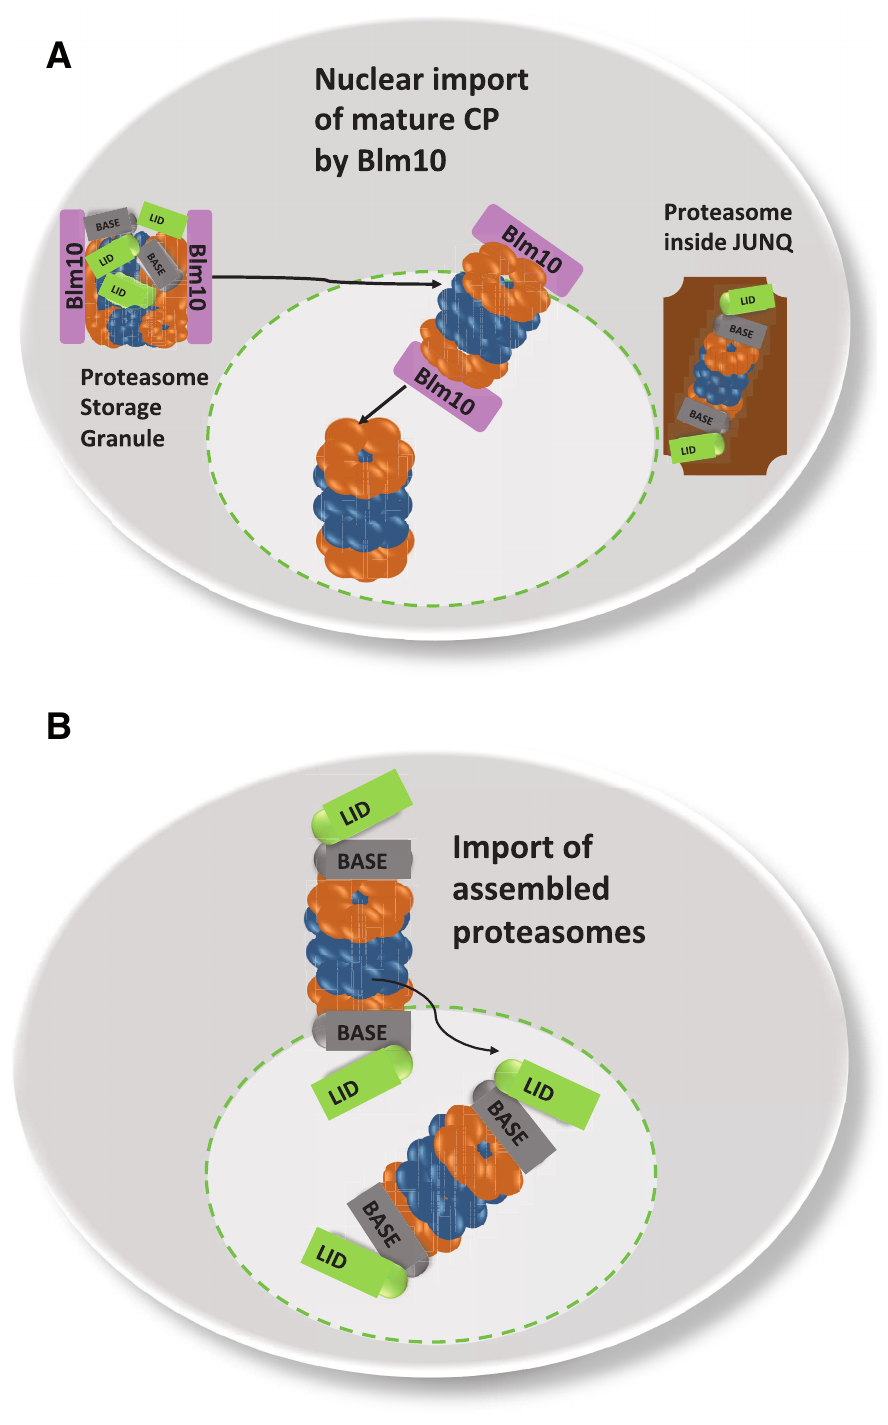
Figure 2. Model of nuclear import of mature proteasomes upon the exit from quiescence. ( A ) In quiescence mature proteasomes are stored in PSG, reversible and motile granules in the cytoplasm. The PSG is formed at the NE/ER with the transition from proliferation to quiescence. The PSG clears with the resumption of growth and mature CP is imported into the nucleus by Blm10. In cell cycle arrested cells as induced by proteasome inhibition, proteasomes reside within JUNQ in the nuclear periphery. JUNQ rapidly clear with the release of proteasome inhibition. ( B ) Assembled holo-proteasomes with RP-CP-RP configuration pass the nuclear